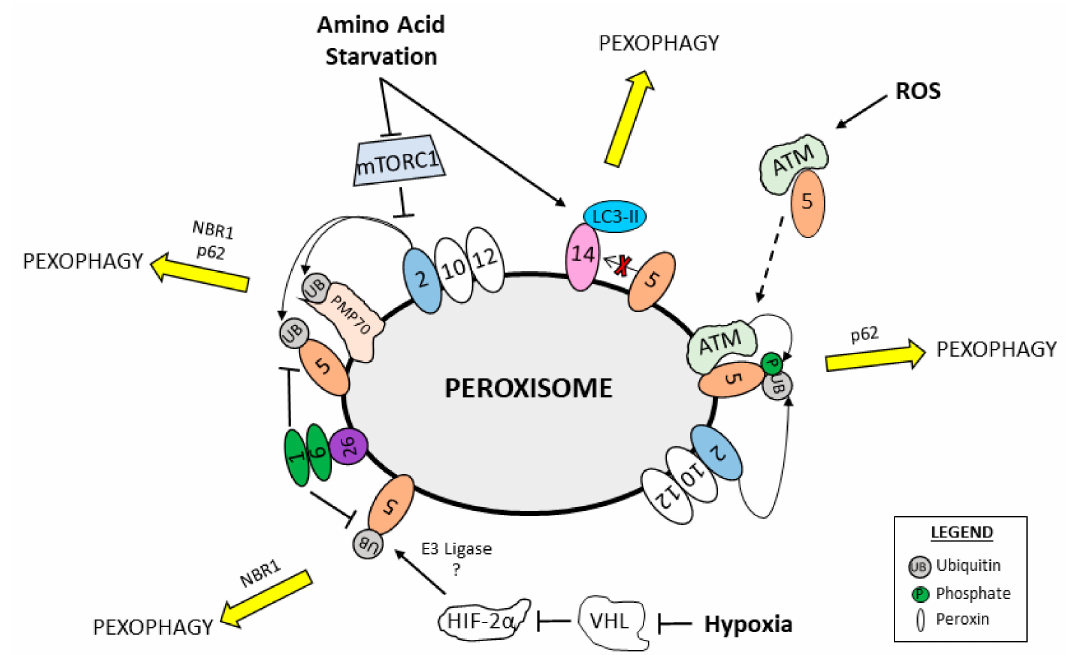
Figure 4. Regulation of mammalian pexophagy. Schematic of ubiquitin-independent and ubiquitin-dependent pexophagy resulting from intracellular and extracellular cues. Amino acid starvation relieves mTORC1 inhibition of the peroxisomal E3 ubiquitin ligase PEX2, allowing PEX2 to ubiquitinate peroxisomal proteins PMP70 and PEX5 and facilitating NBR1 and p62-mediated pexophagy. LC3-II-PEX14 interactions promote pexophagy in an amino acid starvation-dependent mechanism. Increased reactive oxygen species (ROS) levels result in ATM–PEX5 interactions at the peroxisome that promote PEX5 phosphorylation by ATM and ubiquitination by PEX2, to facilitate p62-mediated pexophagy. Hypoxia relieves VHL-mediated inhibition of HIF-2a, resulting in PEX5 ubiquitination by an unknown E3 ubiquitin ligase and NBR1-mediated pexophagy. The peroxisomal AAA-type ATPase complex PEX1-PEX6-PEX26 opposes PEX5-ubiquitination and